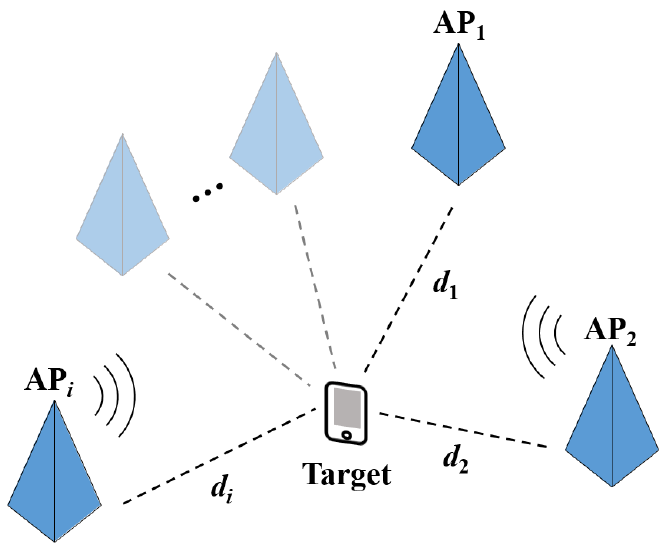
Figure 2. Range-based localization